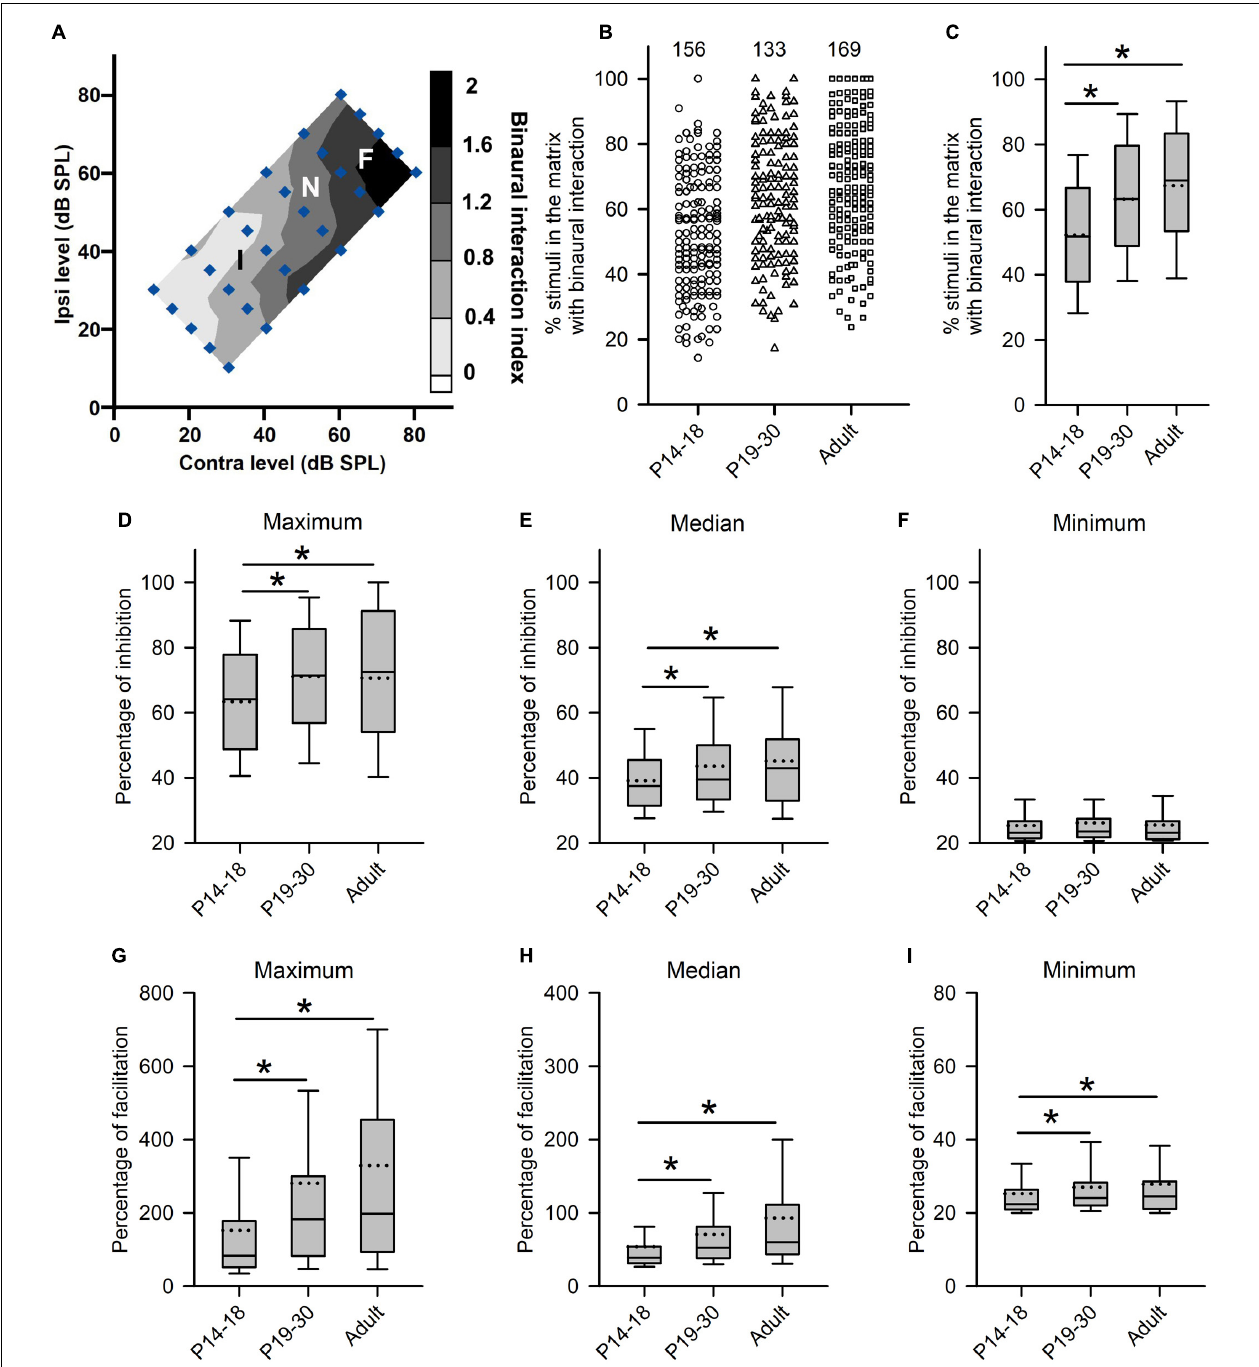
FIGURE 5 | Age-related changes in the degree of binaural interactions of rat AI neurons. (A) Contour plot of the binaural interaction index of a representative AI neuron in responding to the binaural stimulus matrix. F, I, and N: facilitatory, inhibitory, and no binaural interaction evoked by a binaural stimulus in the matrix, respectively. (B,C) The scatter plot (B) and box plot (C) showing the distributions in the percentages of stimuli that evoked binaural interaction in the binaural matrix. Each symbol in panel B represents the data from one neuron. The numbers indicate the number of neurons in each group. (D–F) Box plots showing age-related changes in the degree of inhibitory binaural interaction. The population data for the percentages of inhibition in maximum (D) , median (E) , and minimum (F) are determined from each AI neuron in each group of rats. (G–I) Box plots showing the comparison in the degree of facilitatory binaural interaction among the three groups of AI neurons. The population data for the percentages of facilitation in maximum (G) , media (H) , and minimum (I) are determined from each AI neuron in each group of rats. Box plots indicate the median (solid line in the boxes), mean (dotted line in the boxes), quartiles (box extremities), and 10th/90th percentiles (error bars). * indicates significant difference between two groups (Mann–Whitney U -test, p <